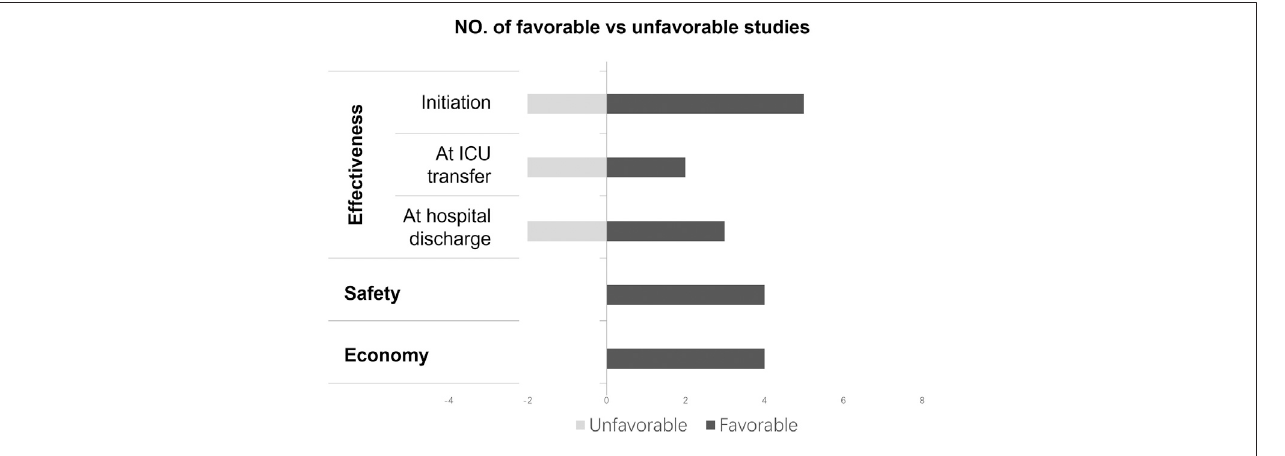
FIGURE 2 | Synthesis of fi nding fromthe included studies (vote